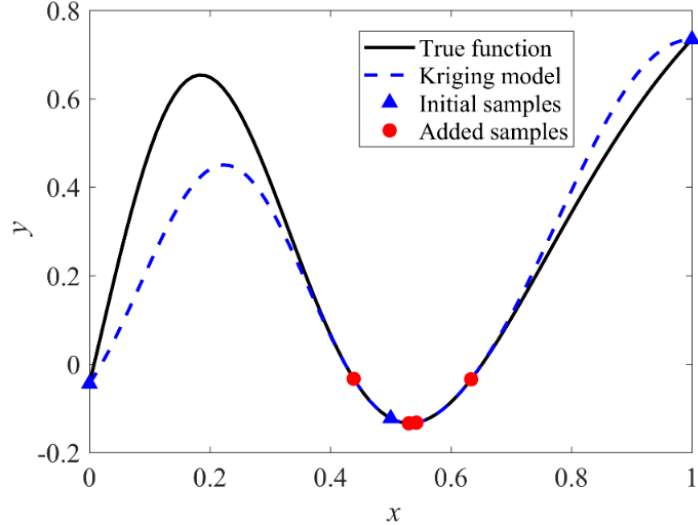
Figure 4. The final result of the proposed approach on the illustrated function.